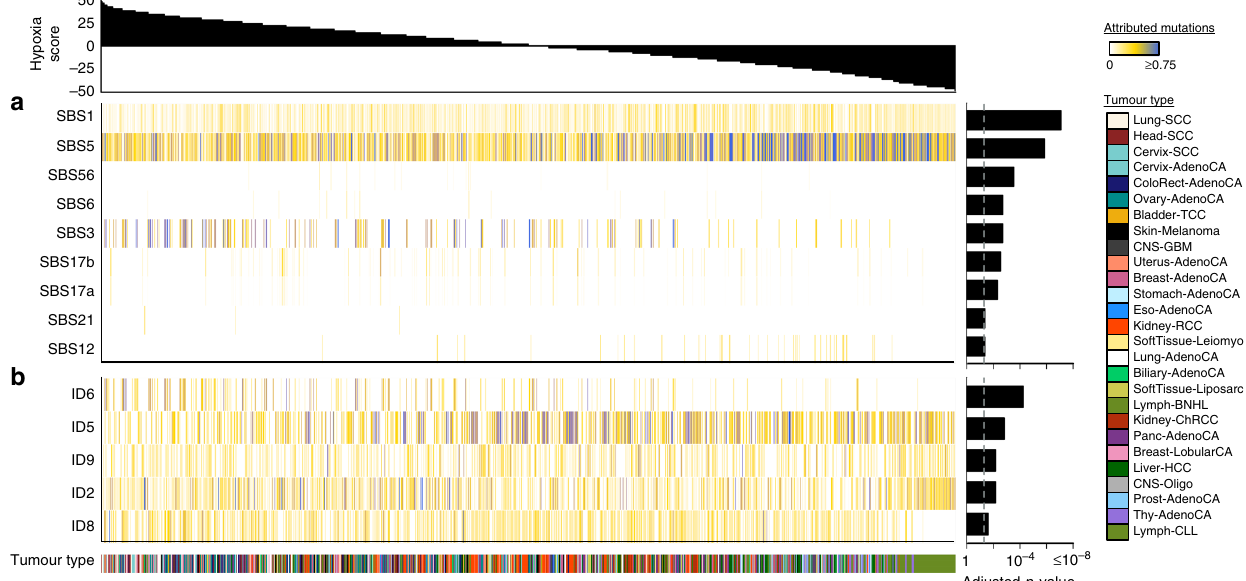
Fig. 3 Hypoxia-associated mutational signatures. We associated hypoxia with the proportion of mutations attributed to speci fi c mutational signatures using linear-mixed effect models. Hypoxia scores for 1188 independent tumours are shown across the top while FDR-adjusted p -values are shown on the right. a Hypoxia was associated with a series of single base substitution signatures with unknown aetiology including SBS5, SBS17a, SBS17b and SBS12. Some of these mutational signatures may re fl ect hypoxia-dependent mutational processes. Hypoxia was also associated with a lower proportion of attributed mutations to SBS1, which re fl ects deamination of 5-methylcytosine, and a higher proportion of attributed mutations to SBS3, which is related to de fi ciencies in DNA double-strand break repair and homologous recombination. b Several signatures of small insertions and deletions were also associated with hypoxia, including ID6 and ID2, which re fl ect defective homologous recombination and defective DNA mismatch repair, respectively. ID5, ID9 and ID4, all with unknown aetiology, were signi fi cantly associated with hypoxia score. All associations were modelled using linear-mixed effect models while adjusting for cancer type, tumour purity, age and